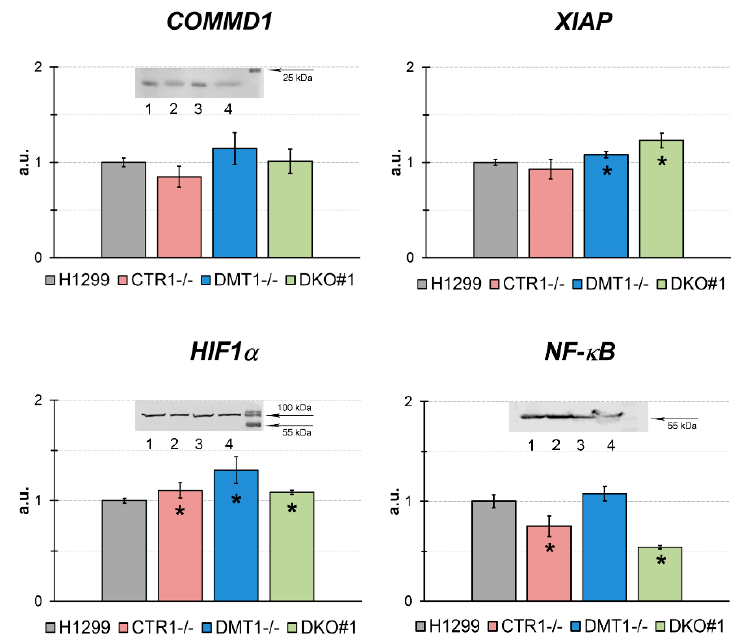
Figure 7. qRT-PCR analysis of concentrations of mature mRNA, which are the products of genes related to the copper regulatory role in the different H1299-derived clones. Y-axis: mRNA levels, a.u. (fold over actin). * p < 0.05 compared with H1299. ( Inserts ) WB analysis: COMMD1, each sample contained 80 µ g protein. HIF1 α , each sample contained 50 µ g protein, and NF- κ B (p65), each sample contained 50 µ g protein. In WB: 1, H1299; 2, CTR1 KO; 3, DMT1 KO; 4, DKO.